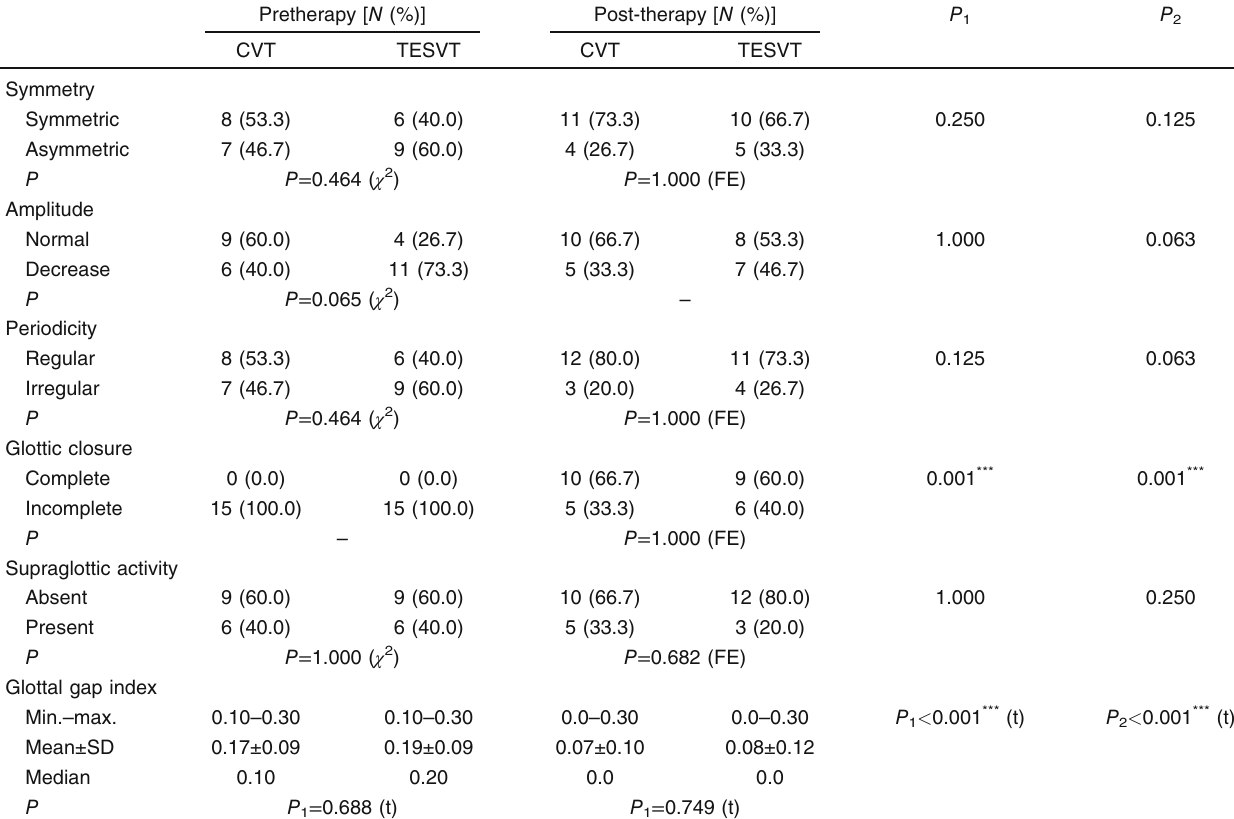
Table 3 Comparison between the studied groups according to stroboscopic findings and the glottal gap index before and after therapy Pretherapy [ N